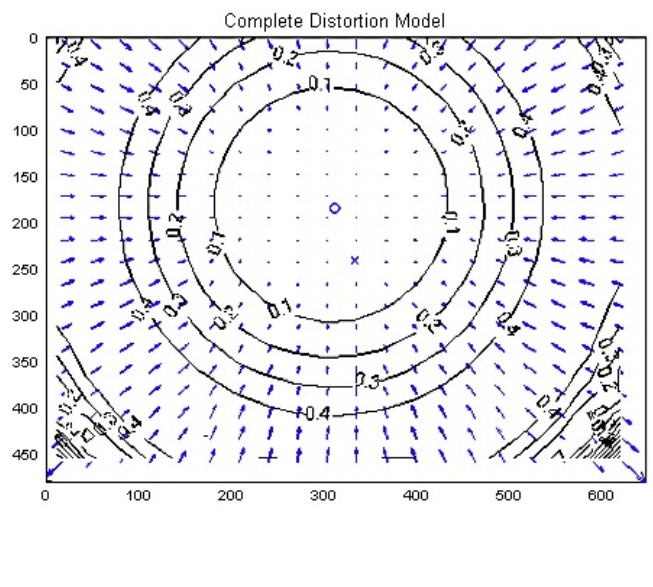
Figure 10. Example of radial distortion of the Nao camera lens: the coefficients marked on each circle represent the factor of distortion induced in each pixel located in that area (units are in